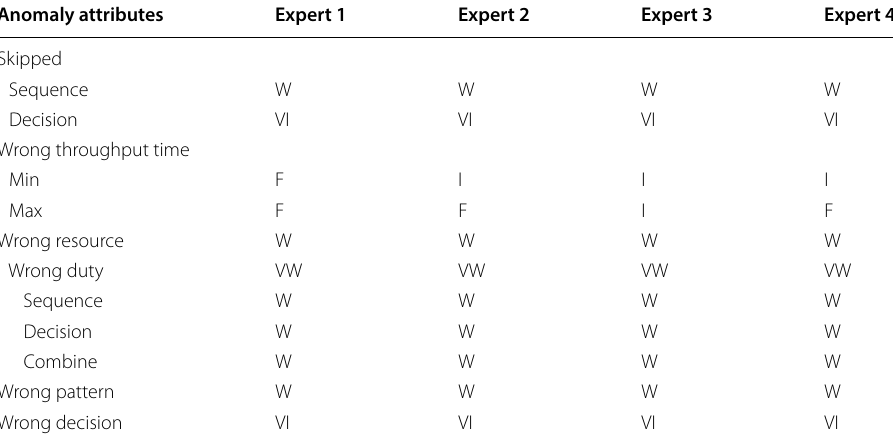
Table 2 Evaluation for each anomaly